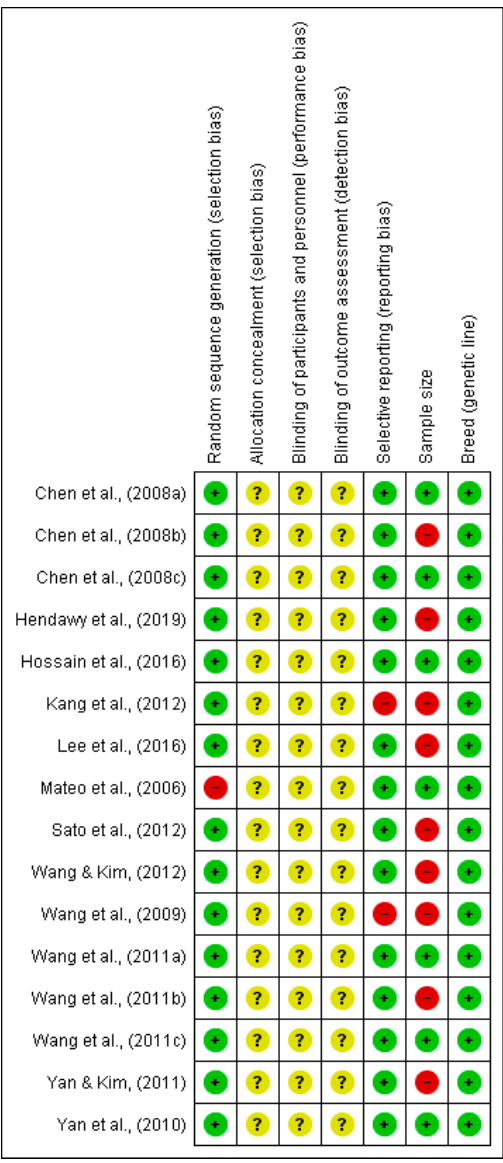
Figure 2. Quality assessment of each included studies.